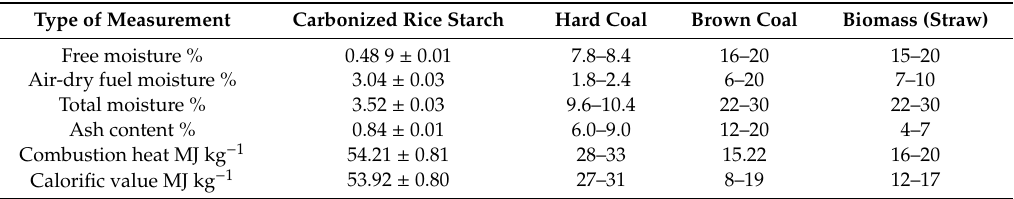
Table 1. Technical properties of biocoal and other